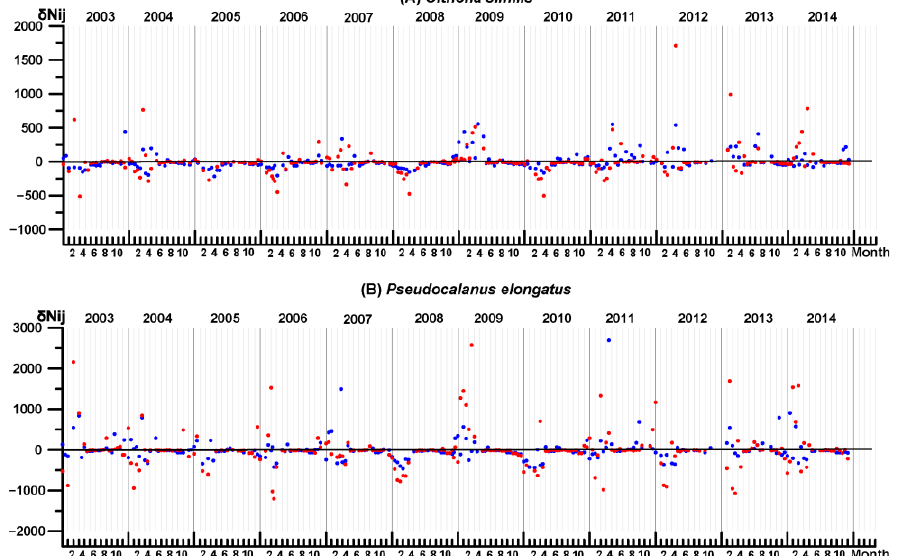
Figure 12. Long-term fluctuations in anomalies of cold-water crustaceans abundance relative to the annual variation (see details of the method in Section 2.4) in Sevastopol Bay at station 1 (blue) and station 2 (red): ( A ) — Oithona similis ; ( B ) — Pseudocalanus elongates. The annual average abundance of P. elongatus ranged between 55 ± 21 ind. m −3 and 352 ± 141 ind. m −3 at station 1 and 130 ± 40 ind. m −3 and 598 ± 228 ind. m −3 at station 2. The maximum seasonal abundance of P. elongatus occurred in February and March, the